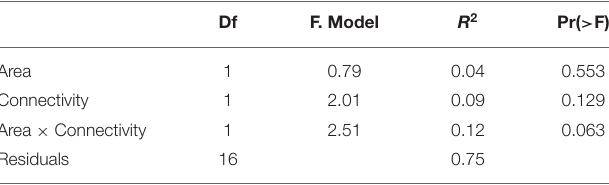
TABLE 7 | Parameter estimates and P- values for the Permanova analysis built to test the effect of area and connectivity on ant species community composition in 20 habitat